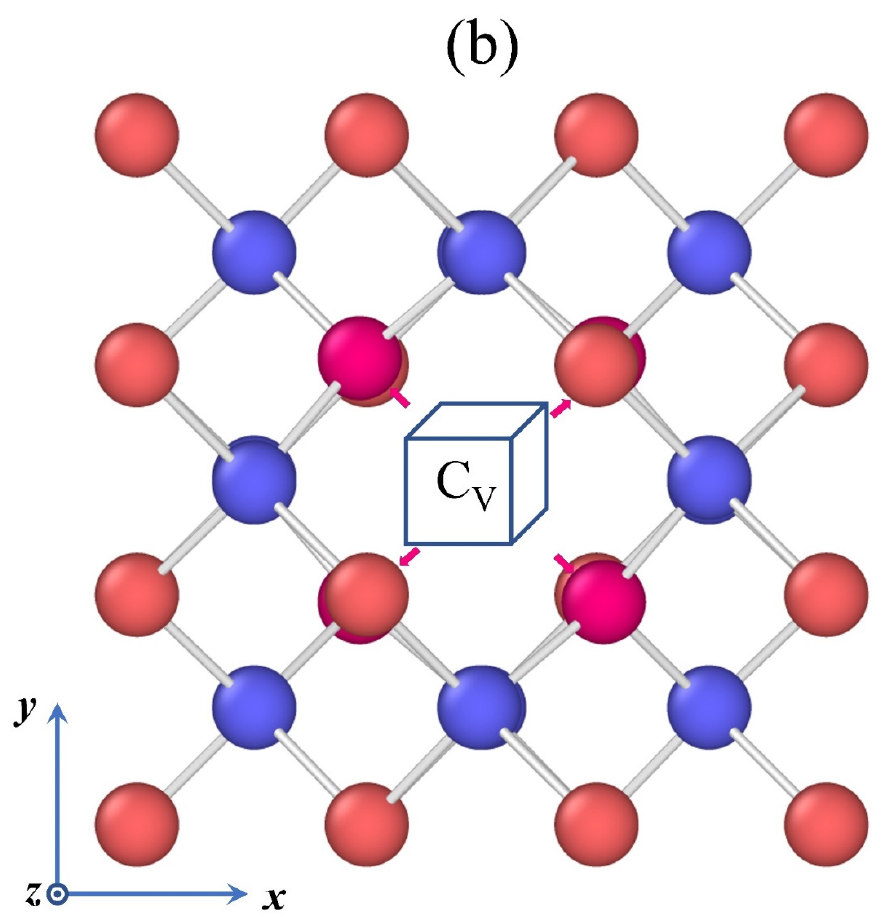
Figure 1. ( a ) The initial supercell without defects (the size is 20 a × 20 a × 20 a ), ( b ) the structure near one C V . The blue sphere represents the C atom, the red sphere represents the Si atom and the deep-pink sphere pointed by the arrow represents the first neighbor Si atom of C V , the directions of the arrows denote the offset of these first neighbor Si atom from the initial lattice position.